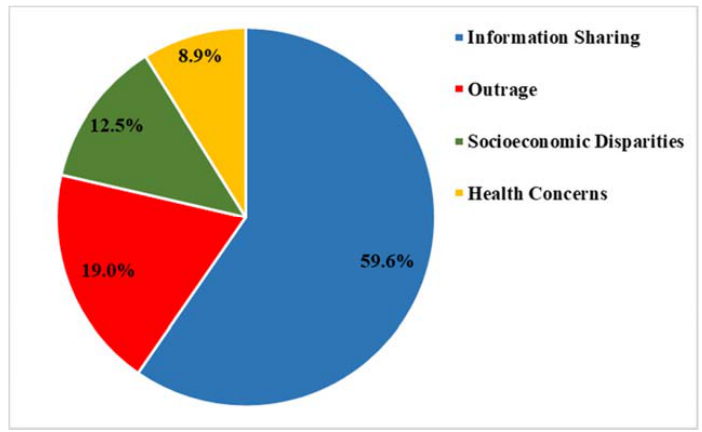
Figure 2. Thematic categories.